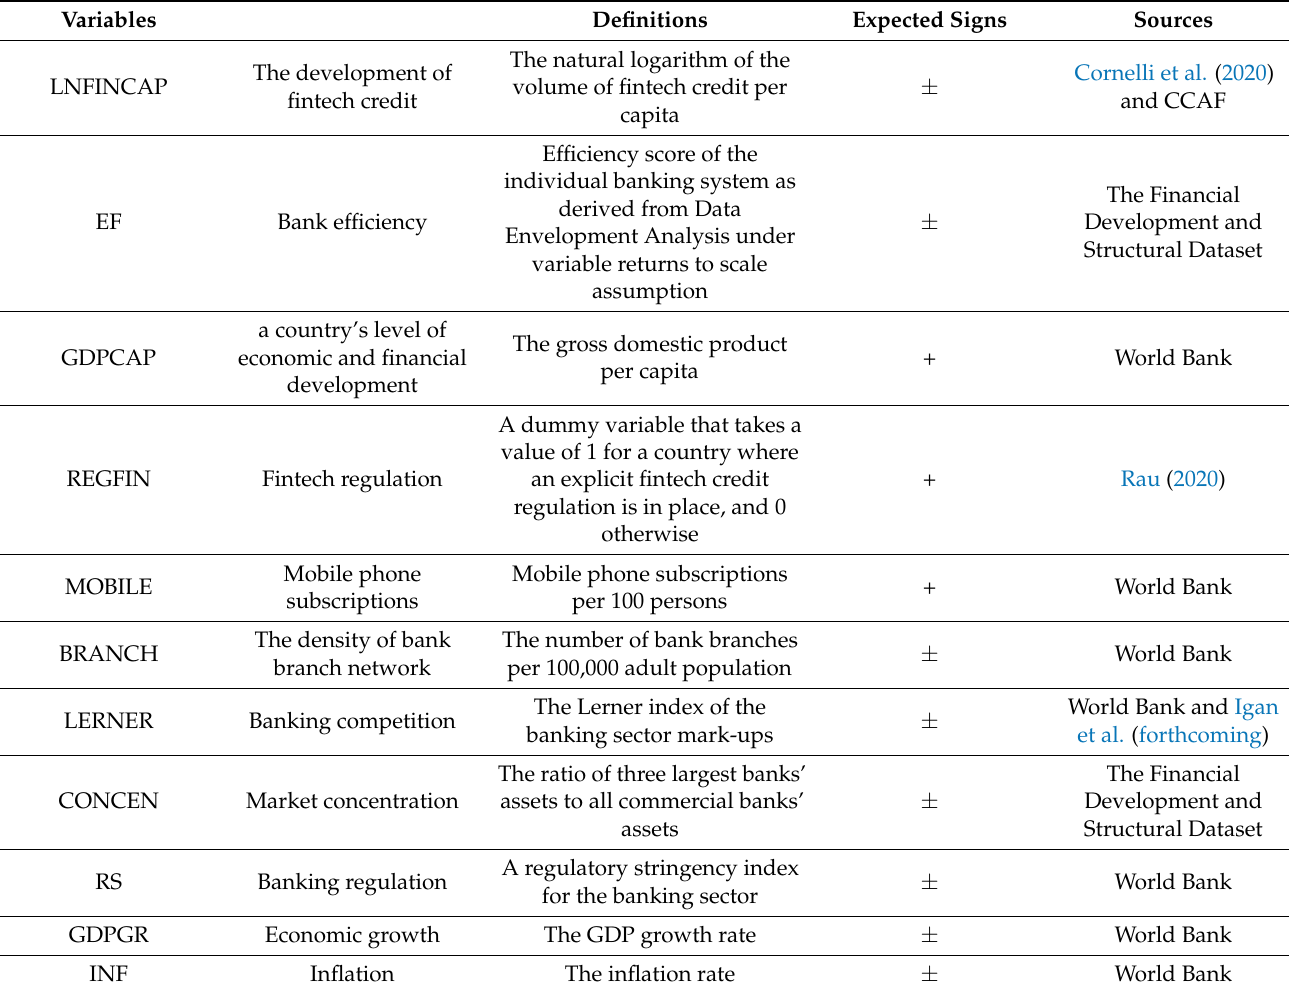
Table A2. A summary of variables used in SEM and their expected signs.